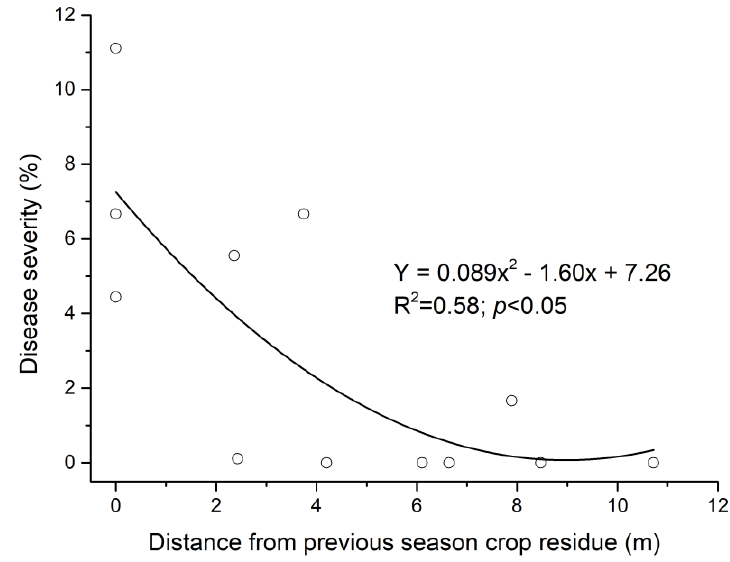
Figure 10. Relationship between disease severity and the distance of the Zhana plots from the previous season’s Zhana crop. season’s Zhana